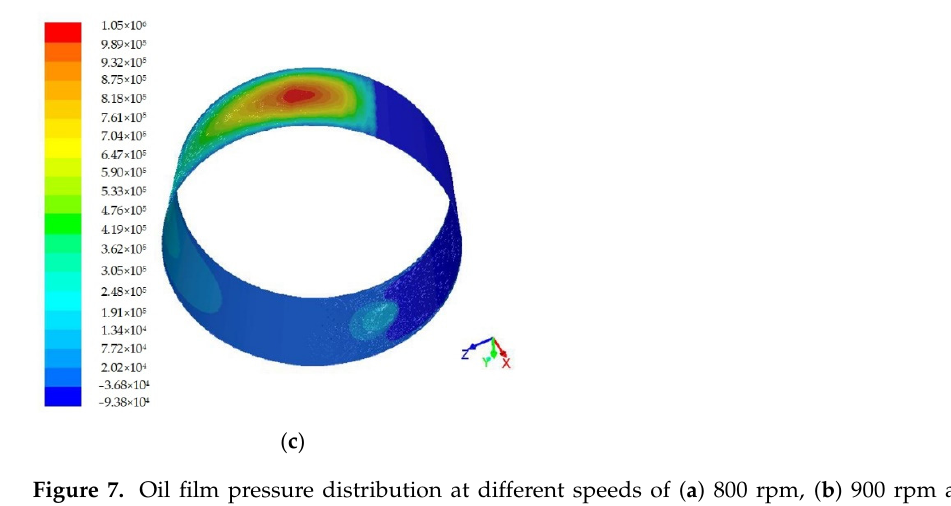
Figure 7. Oil film pressure distribution at different speeds of ( a ) 800 rpm, ( b ) 900 rpm and ( c ) 1000 rpm.